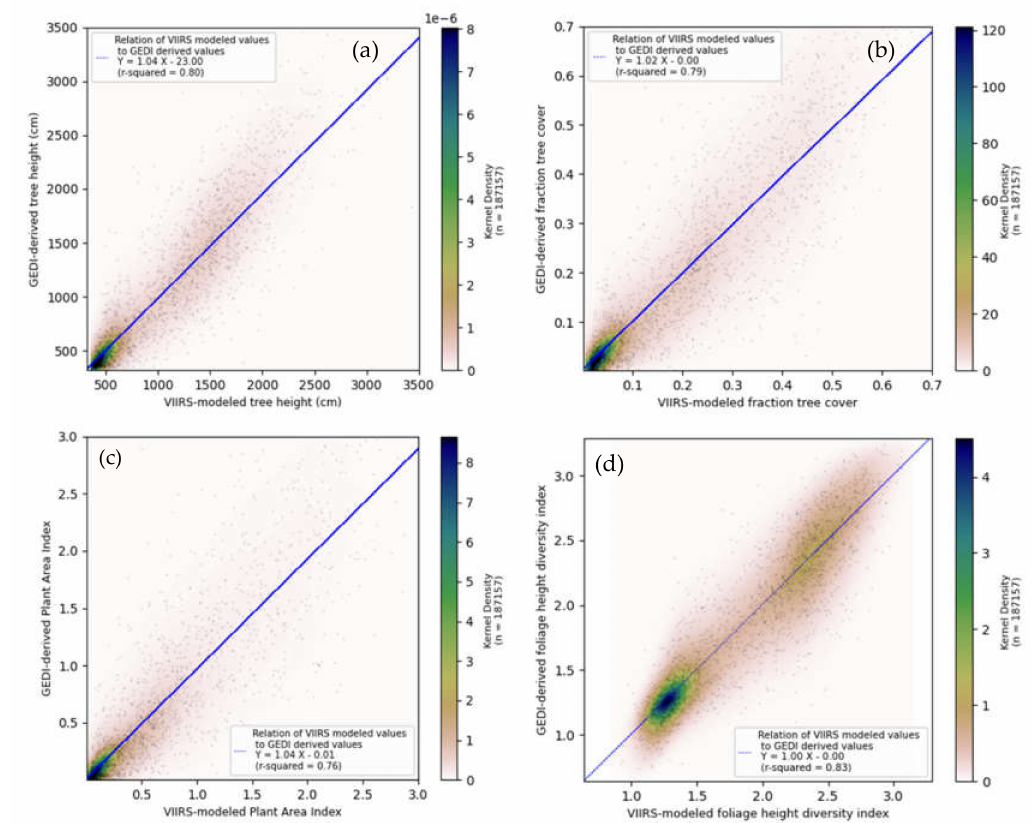
Figure 2. Comparisons between VIIRS modeled and GEDI-derived: ( a ) canopy height; ( b ) canopy fraction cover; ( c ) plant area index; and ( d ) foliage height diversity. For graphical clarity purpose, the scatter points are a representation of a random selection of small subset from the validation dataset.